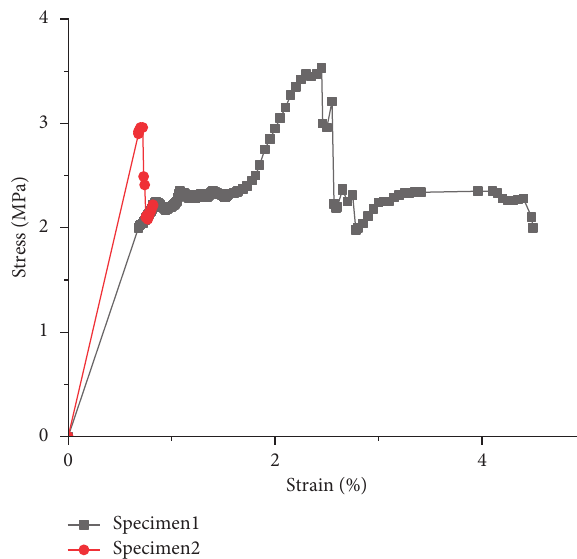
Figure 5: Stress-strain relationship of the SHCC